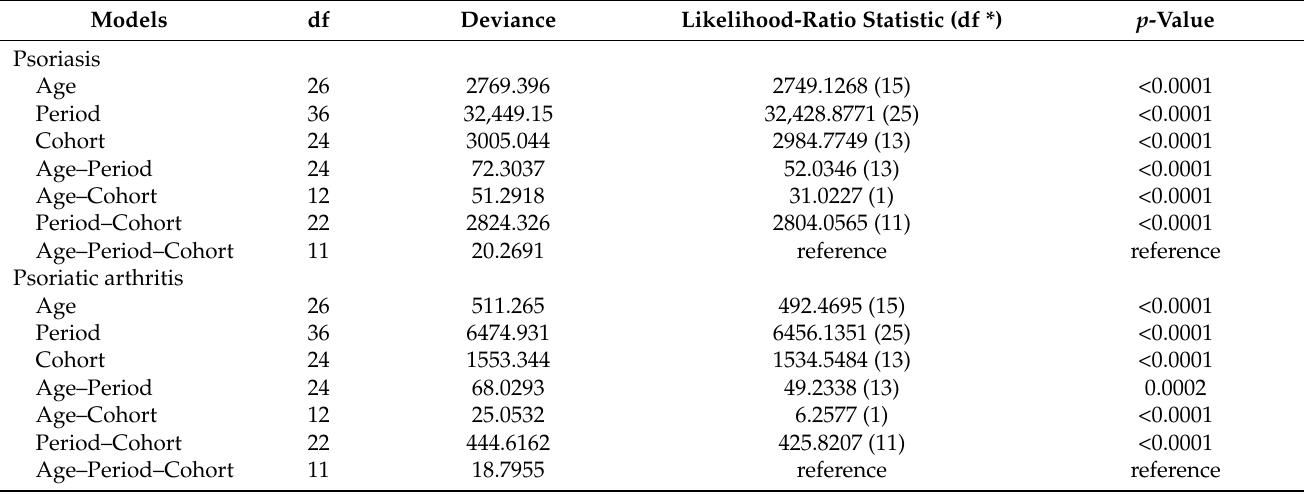
Table 2. Goodness-of-fit of age–period–cohort model assessment for psoriasis and psoriatic arthritis incidence